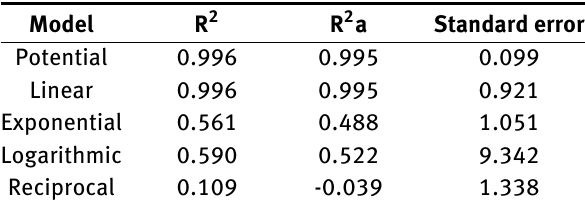
Table 2: Values of R 2 , R 2 a and standard error.